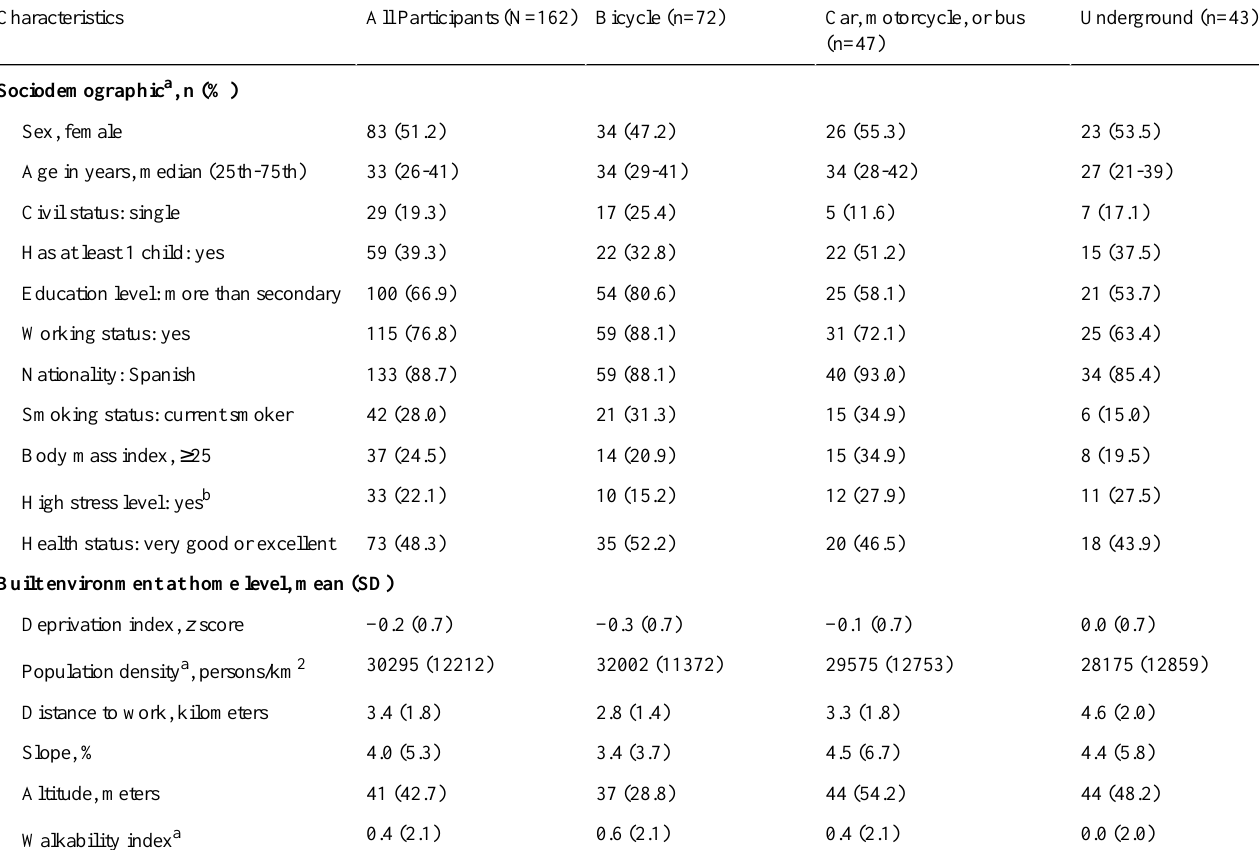
Table 1. Description of participants’sociodemographic and home characteristics according to the main commute mode.